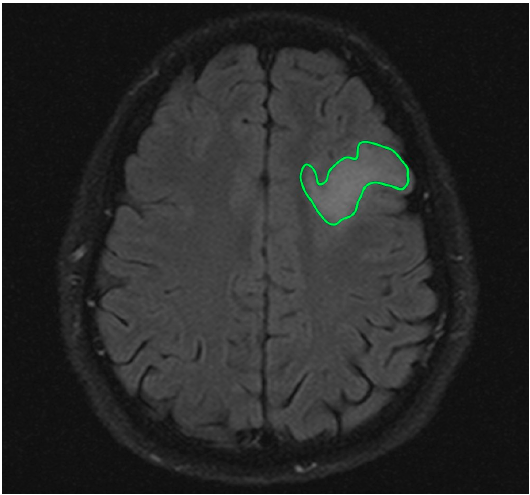
Figure 1. Axial ROI of low-grade glioma in T2 Flair sequences.